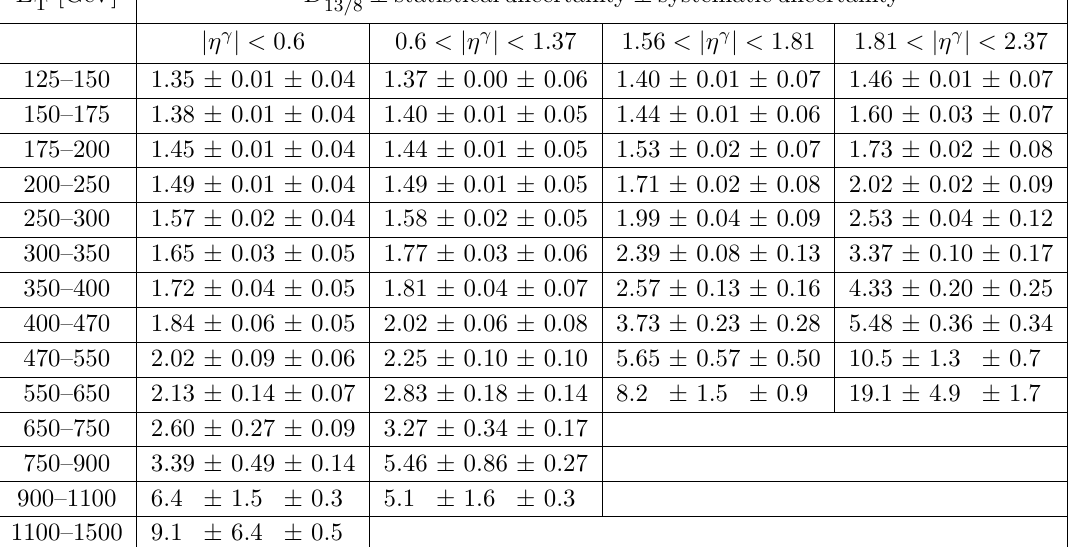
as a function of E (cid:13) together with the statistical and total systematic T 13 = 8